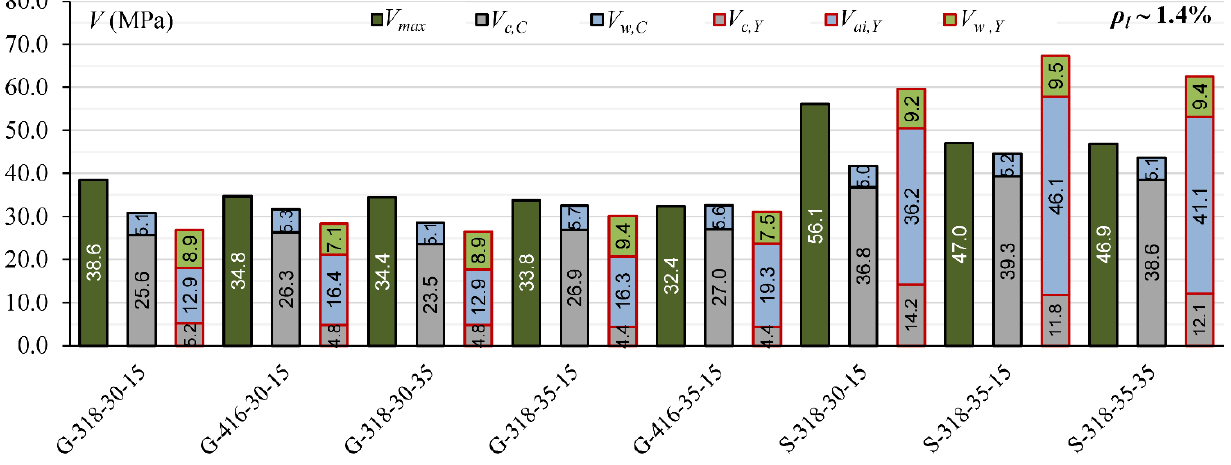
Figure 9. The comparison of shear mechanism contribution for steel-reinforced beams with rein- forcement ratio ρ l ~ 1% for Cladera et al.’s and Yang’s models.